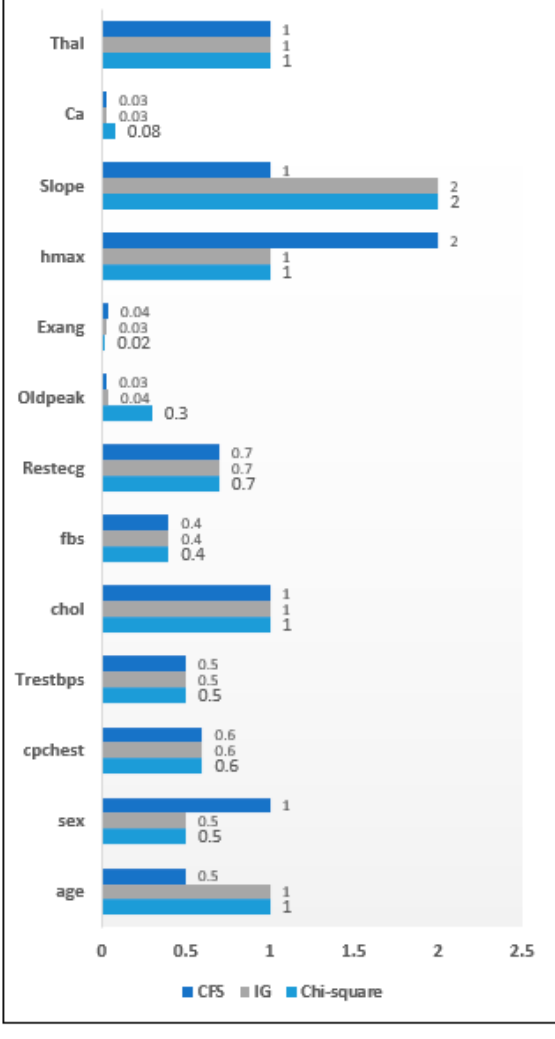
Figure 7. Attribute Significance Graph for the Diabetes dataset with Filters.